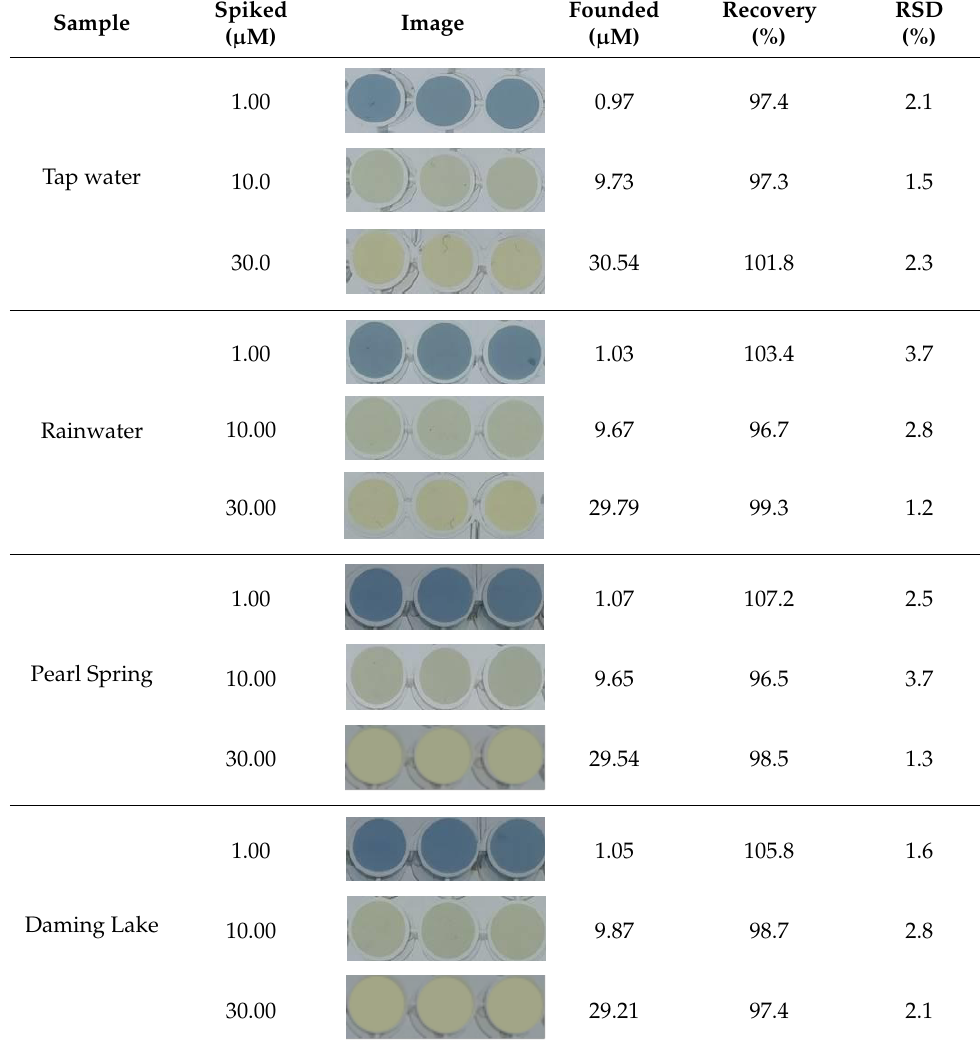
Table 1. Determination of Cr(VI) in actual samples by colorimetric method.